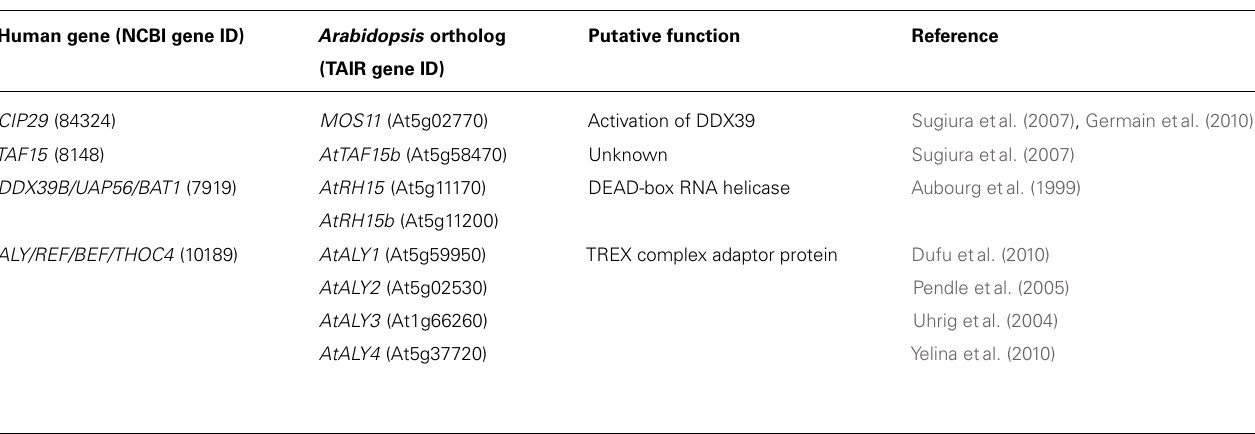
Table 1 | CIP29 interacting proteins and their putative orthologs in Arabidopsis